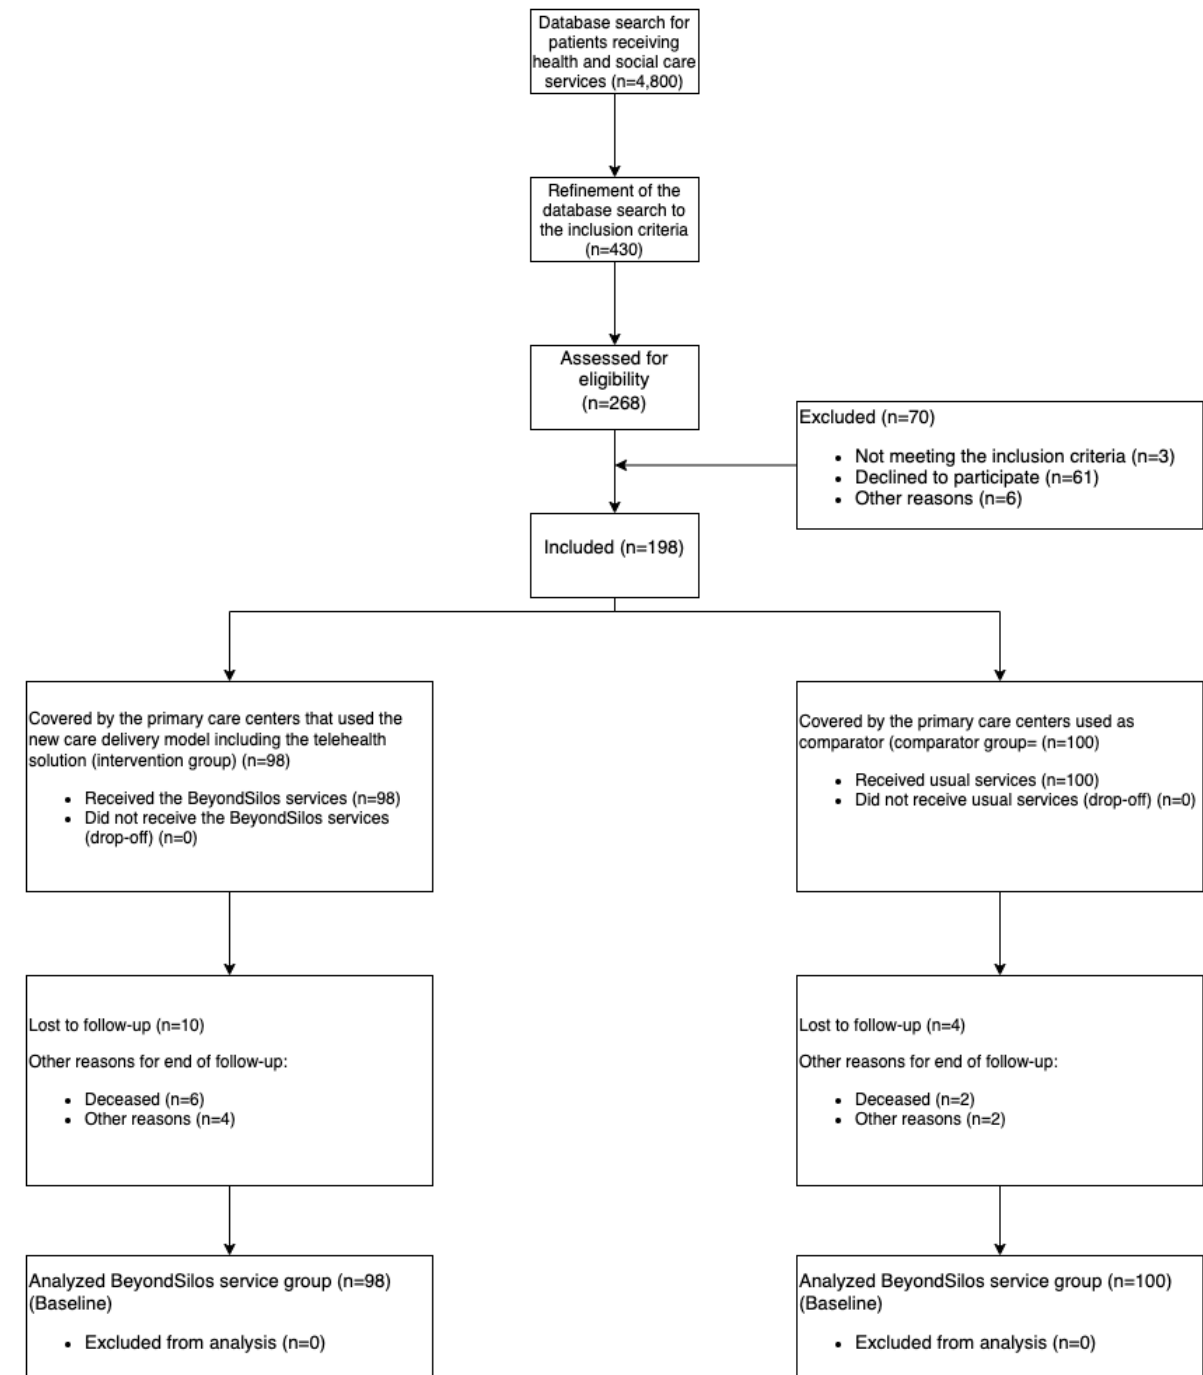
Figure 2. Flowchart of participant recruitment for the BeyondSilos project.